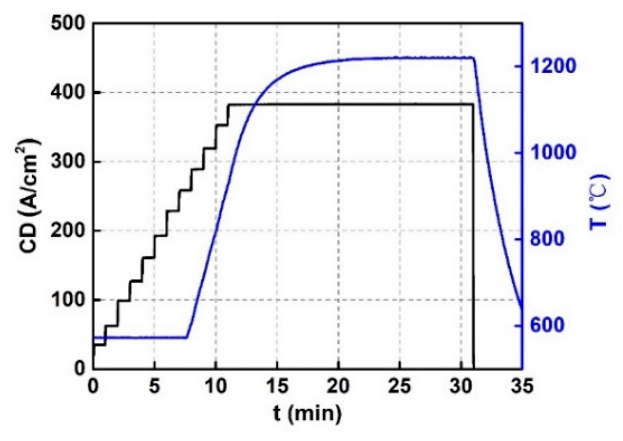
Figure 4. The change curves of current density (CD) and temperature during the FAST joining process of W foil laminate in an artificial operation mode.